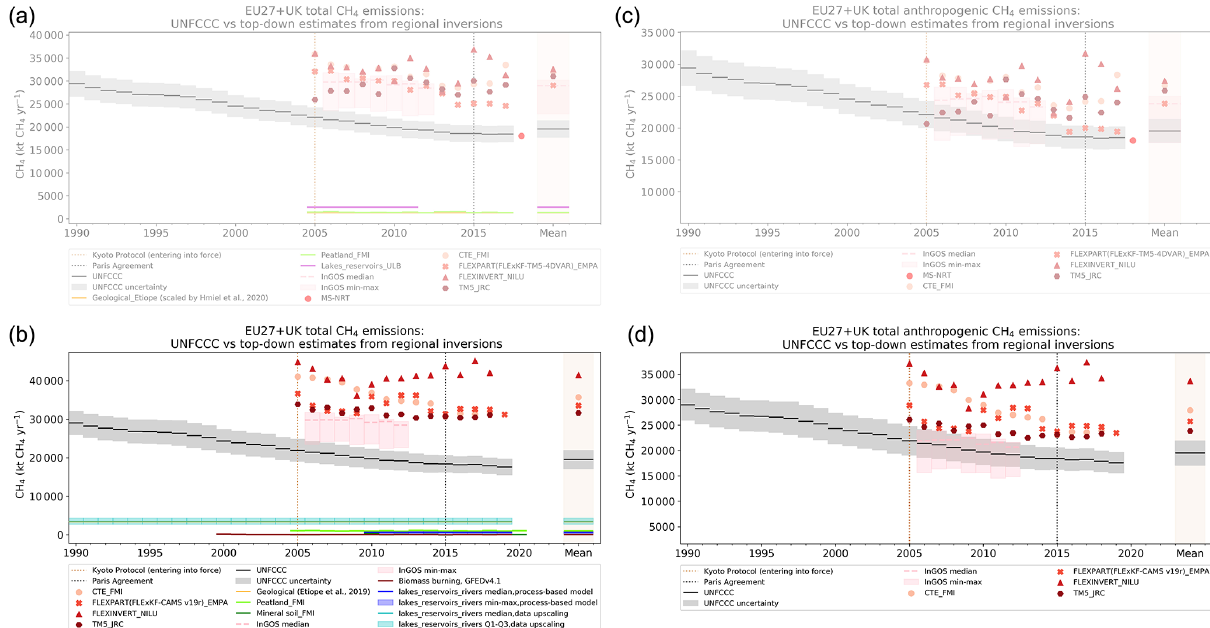
Figure 4. (a, b) Comparison of total CH 4 emissions for the EU27 + UK from four top-down regional inversions with UNFCCC NGHGI (gray) data and two estimates for inland waters (lake, river and reservoir process-based models, blue, and upscaled emissions, cyan), peat- lands and mineral soils (from JSBACH–HIMMELI, light green and dark green), geological emissions (orange), and biomass burning (from GFEDv4.1, brown) as follows: (a) previous data from Petrescu et al. (2021), current study. (c, d) Comparison of anthropogenic CH 4 emis- sions from four top-down regional inversions with UNFCCC NGHGI (gray) data as follows: (c) previous data from Petrescu et al. (2021), current study. Anthropogenic emissions from these inversions are obtained by removing natural emissions and biomass burning from total TD CH 4 emissions shown in Fig. 4a and b. UNFCCC NGHGI (2021) reported uncertainties computed with the error propagation method (95% confidence interval) were calculated for each year of the time series and represent the gap-filled harmonized member-state-reported uncertainty for all sectors (including LULUCF). The time series mean was computed for the common period of 2005–2018 between datasets (excluding